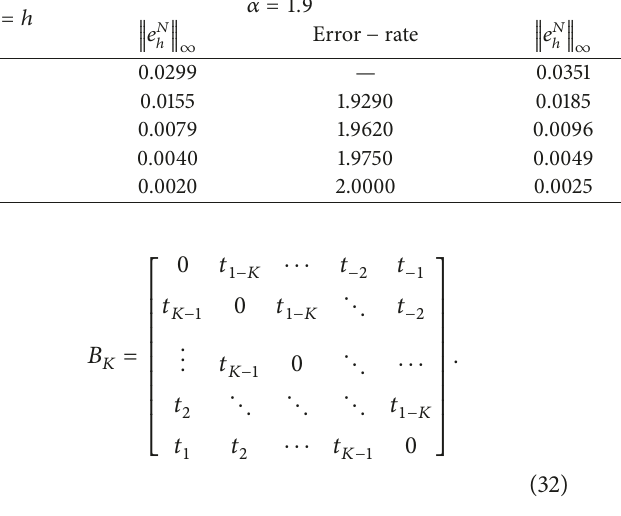
Table 1: Error behavior for the implicit finite difference scheme (7), for example, at time 𝑇 = 1 and 𝛽 = 1.0 . 𝛼 = 1.9 Δ𝑡 = ℎ